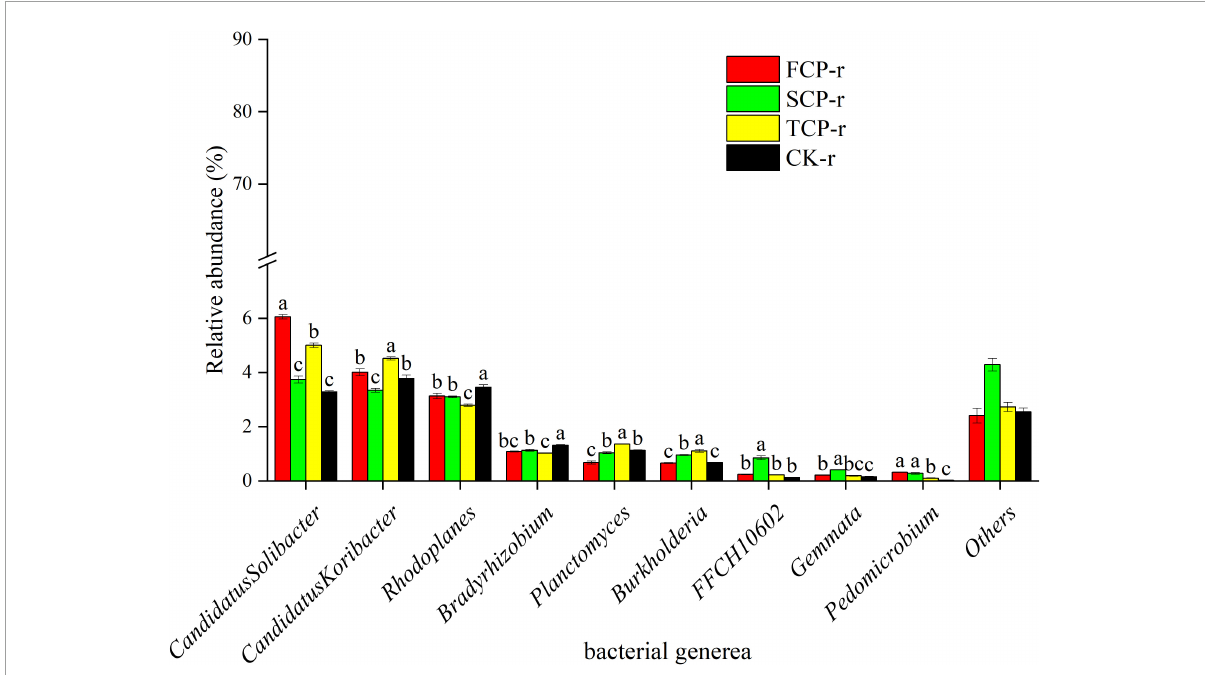
FIGURE4 Relative abundance of predominant bacterial community in successive generations within rhizosphere soil at the genus level. Other stands for undefined categories. Value show means ± standard error ( n = 3). Different lowercase letters show significant differences. CK, Nanmu seedings; FCP, first-generation seedings; SCP, second-generation seedings; TCP, third-generation seedings. r, rhizosphere soil.